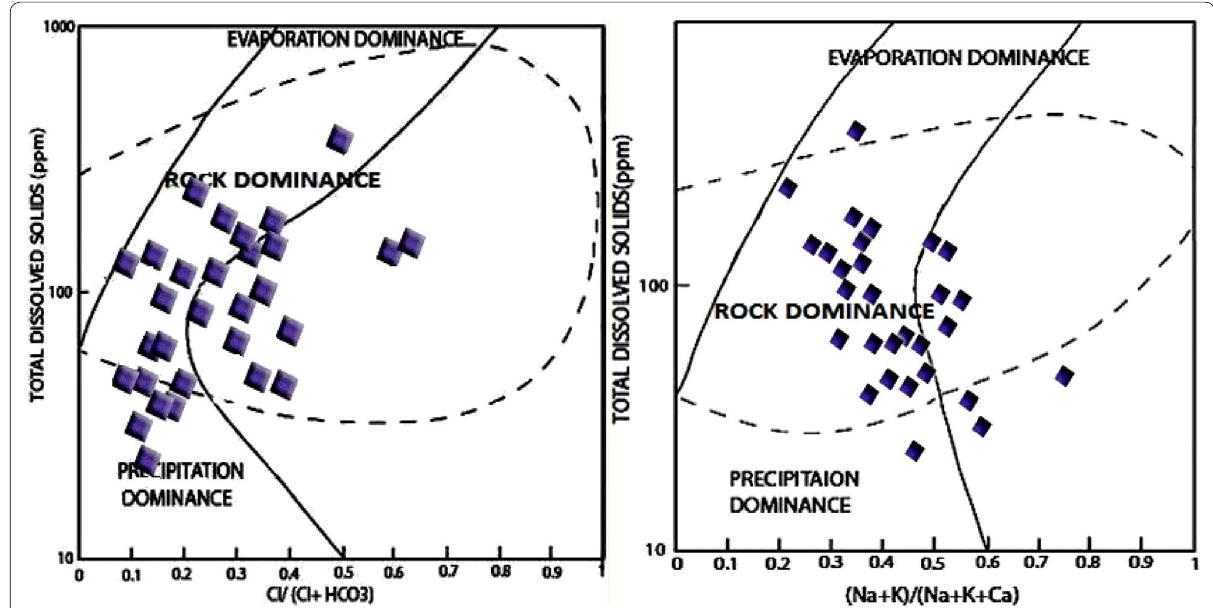
Fig. 6 GR for different samples are plotted alongside their relevant total dissolved